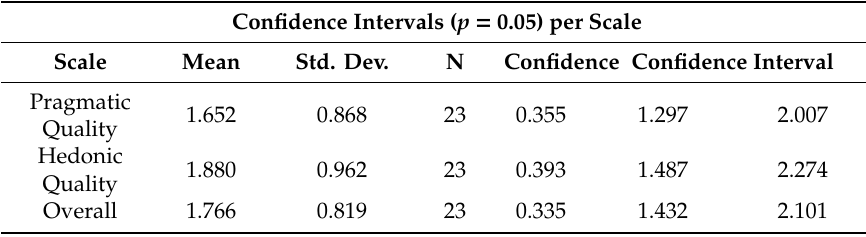
Table 3. Mean for UEQ-S